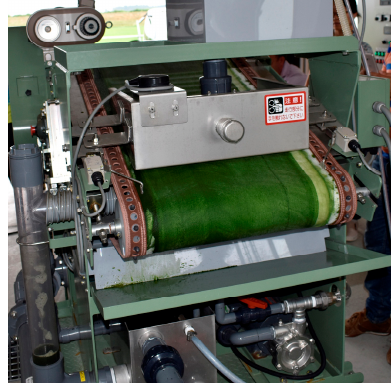
Figure 7. Drum filter equipment at Minamisoma (1.42 kW, 520 kg/h).